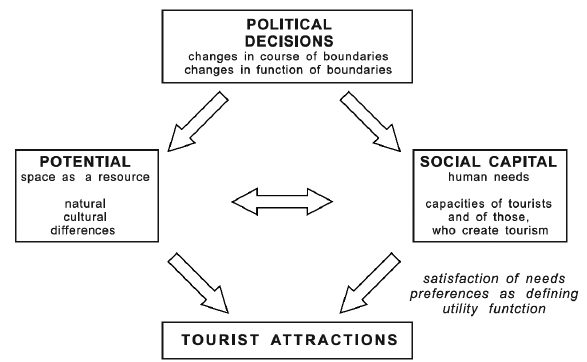
Fig. 1. The influence of the most important elements on the tourist attractiveness of a near-border area (after Więckowski 2010). Source: own